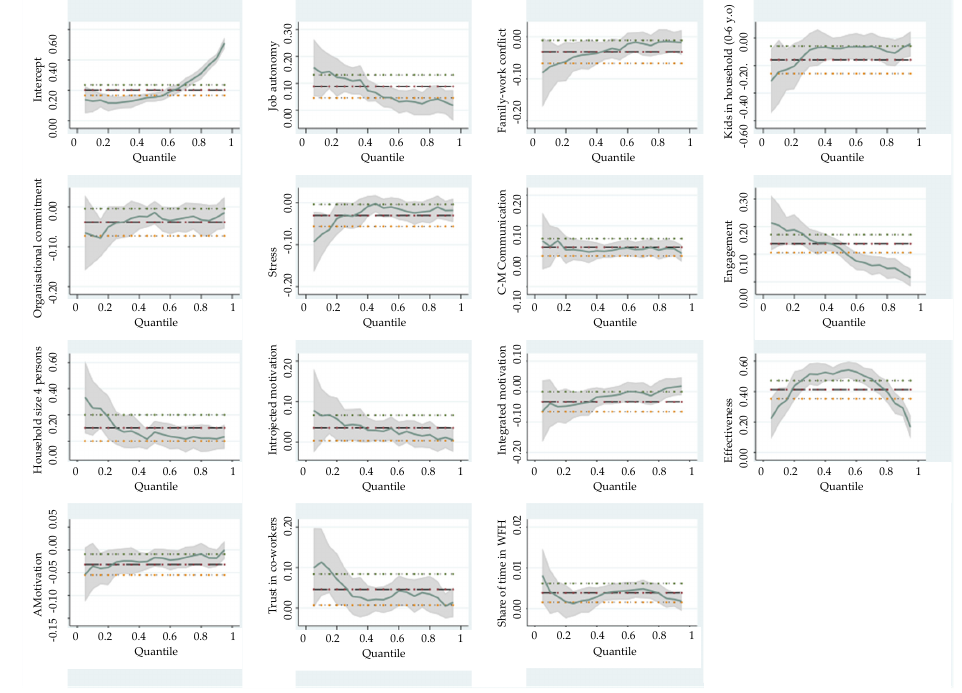
Figure 4. OLS and QR estimates for technical performance model.